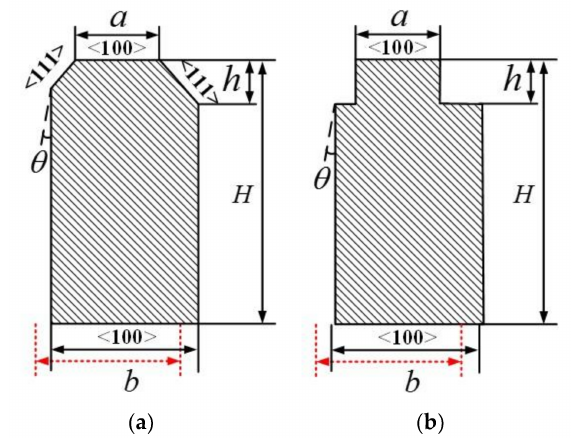
Figure 8. Fabrication imperfections of two kinds of oblique beam cross-section. ( a ) Polygonal cross-section; ( b ) convex